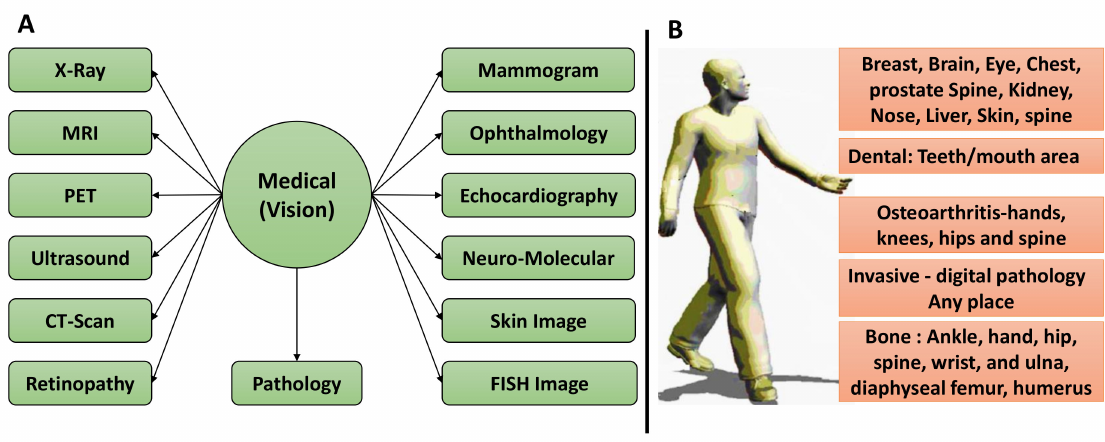
Figure 5. The imaging modality and body parts for ML and CV for clinical studies. ( A ) Different imaging modalities can be used for CV and image processing. ( B ) Imaging from different body parts of